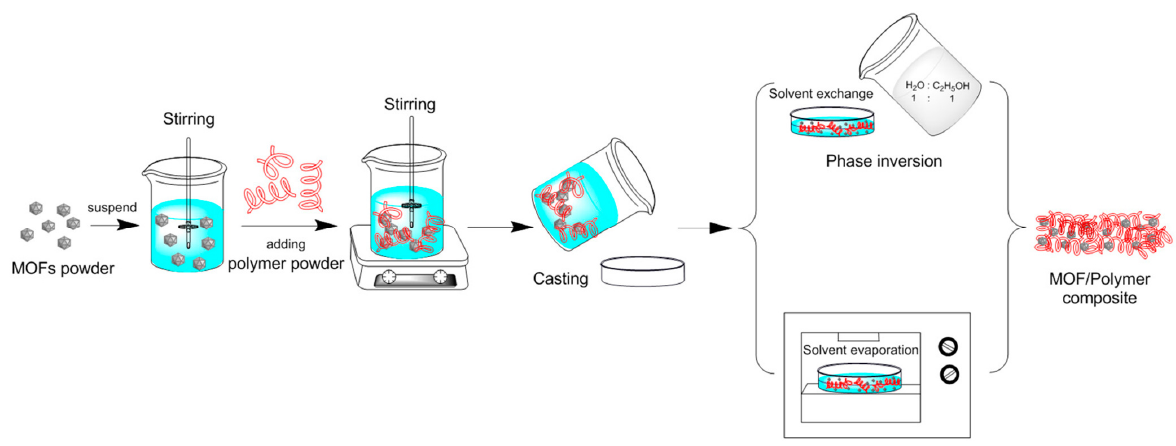
Figure 11. MOF/polymer composite prepared by evaporative solvent method [104].